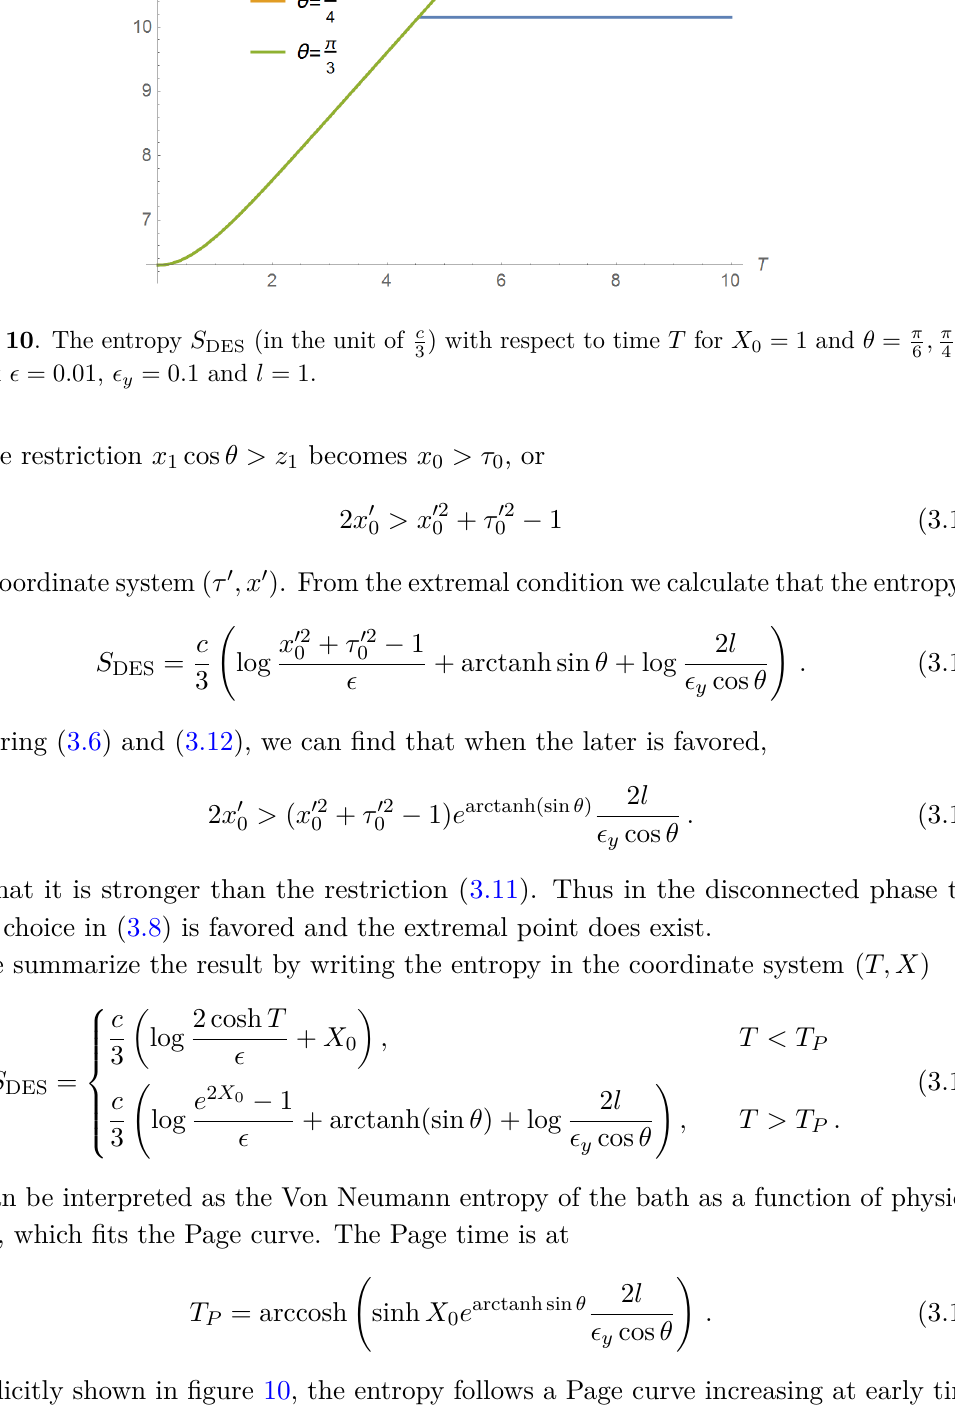
) with respect to time T for X 0 = 1 and θ = π 3